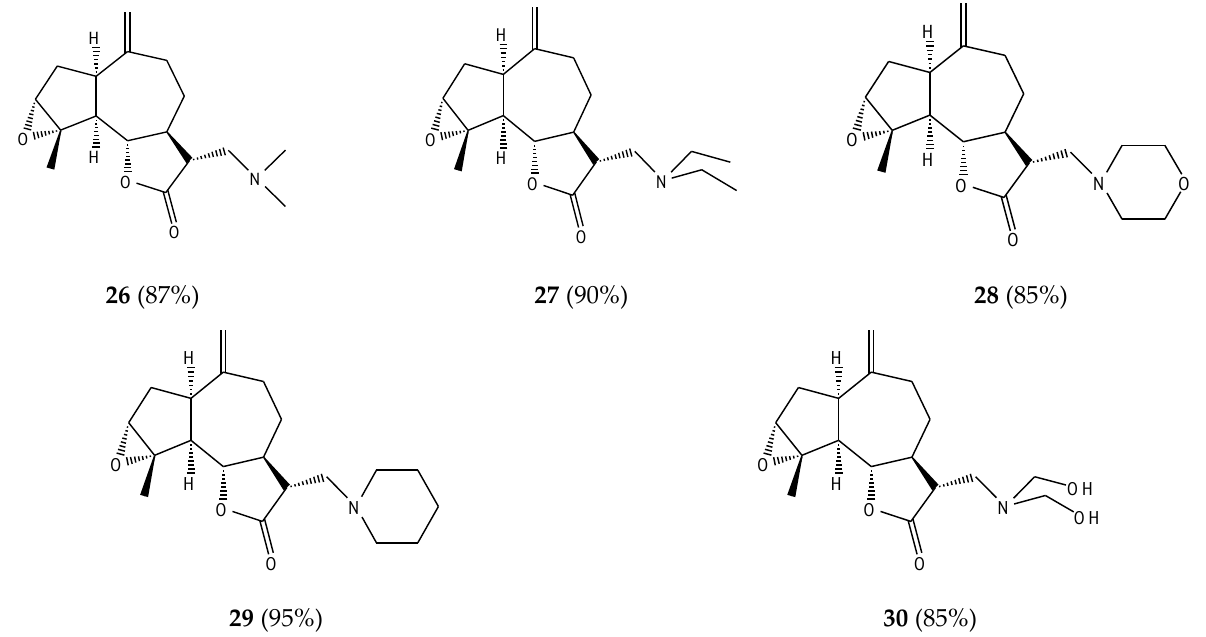
Figure 5. Structures of amino derivatives of estafiatin 26 – 30.